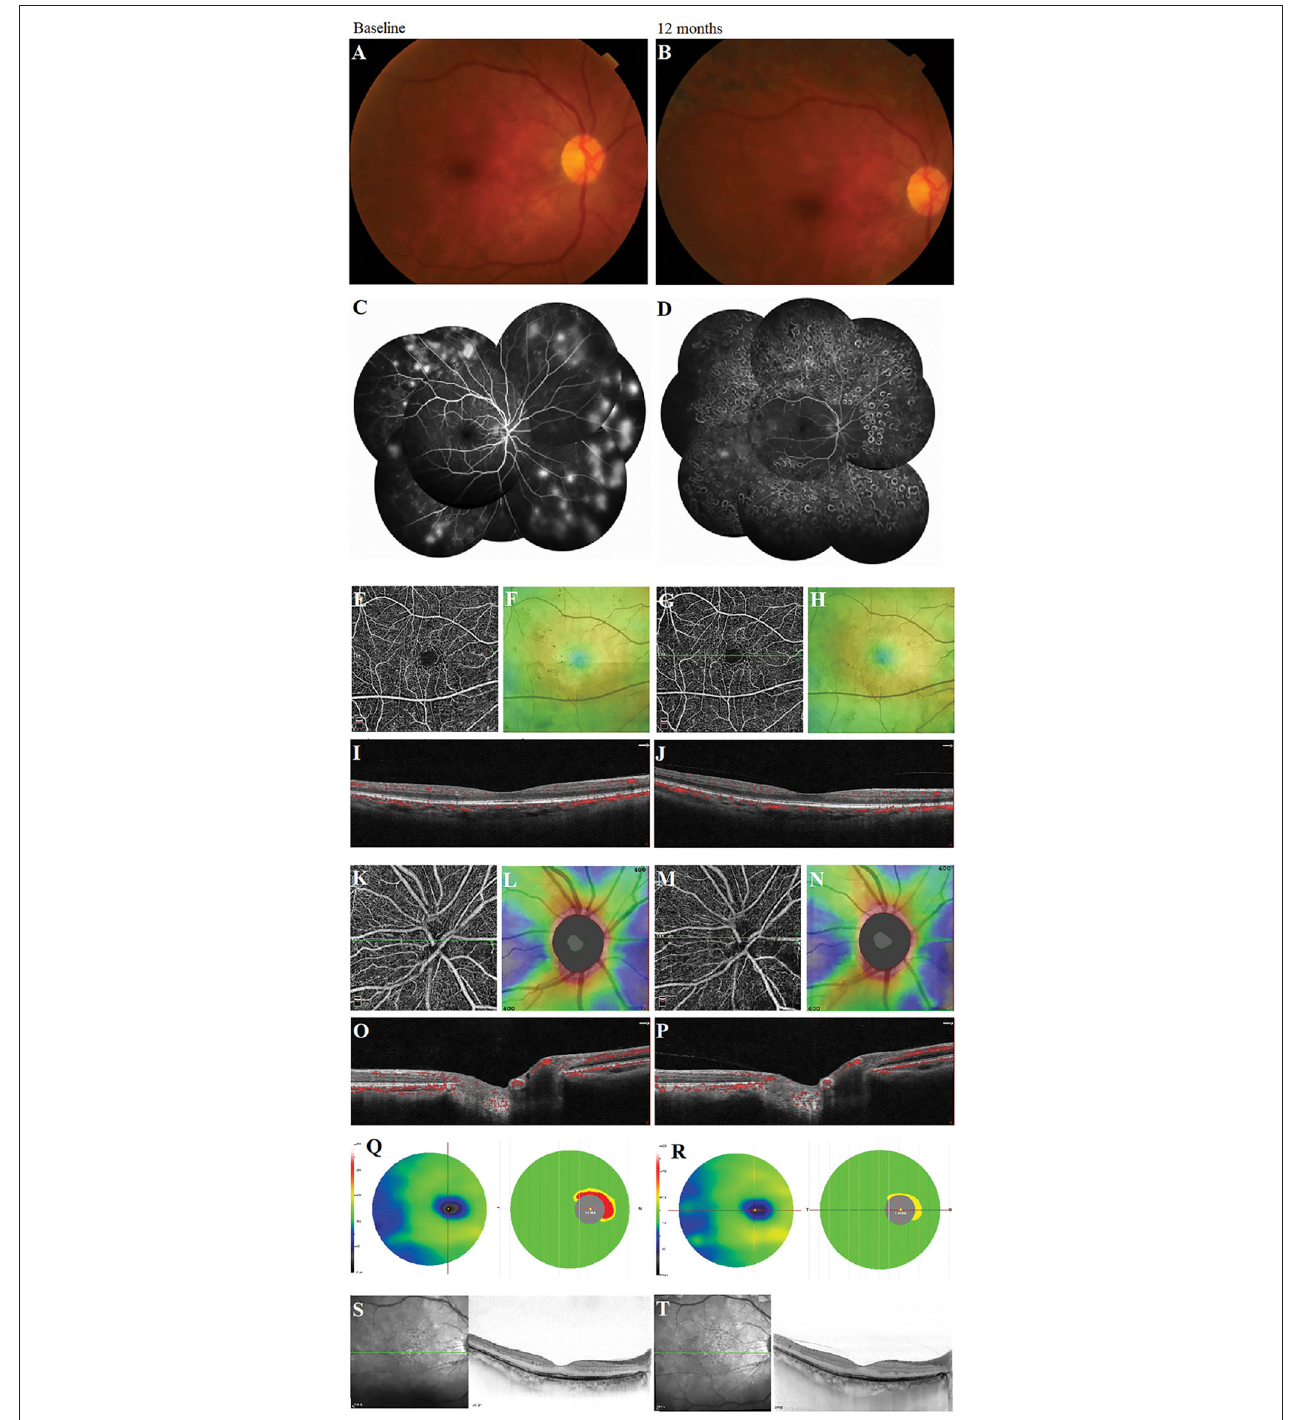
FIGURE 4 | A typical proliferative diabetic retinopathy case showed the retinal neovascularization regression with the unchanged vessel density, the thickness of retinal nerve fiber layer and ganglion cell complex, and subfoveal choroidal thickness at 12 months after panretinal photocoagulation (PRP) in the multimodal images. (A,B) Images of color fundus photography. (C,D) Images of fundus fluorescein angiography. (E,G) Retina en-face slab images in HD Angio Retina 6.0mm scan by optical coherence tomography angiography (OCTA). (F,H) Full retinal thickness images in HD Angio Retina 6.0mm scan of OCTA. (I,J) B-scan images in HD Angio Retina 6.0mm scan of OCTA. (K,M) Retina en-face slab images in HD Angio Disk 4.5mm scan by OCTA. (L,N) Retinal nerve fiber layer thickness images of OCTA. (O,P) B-scan images in HD Angio Retina 6.0mm scan of OCTA. (Q,R) Ganglion cell complex scan images of OCTA. (S,T) Images of the OCT with the enhanced depth-imaging (OCT-EDI)